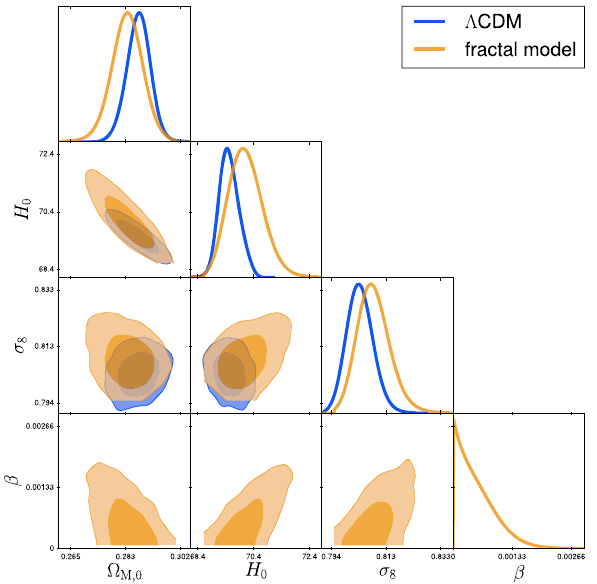
Fig. 4 The one-dimensional posterior distribution and two- dimensional posterior contours with 68% and 95% confidence limits for the selected cosmological parameters of fractal model (orange) compared to (cid:3) CDM